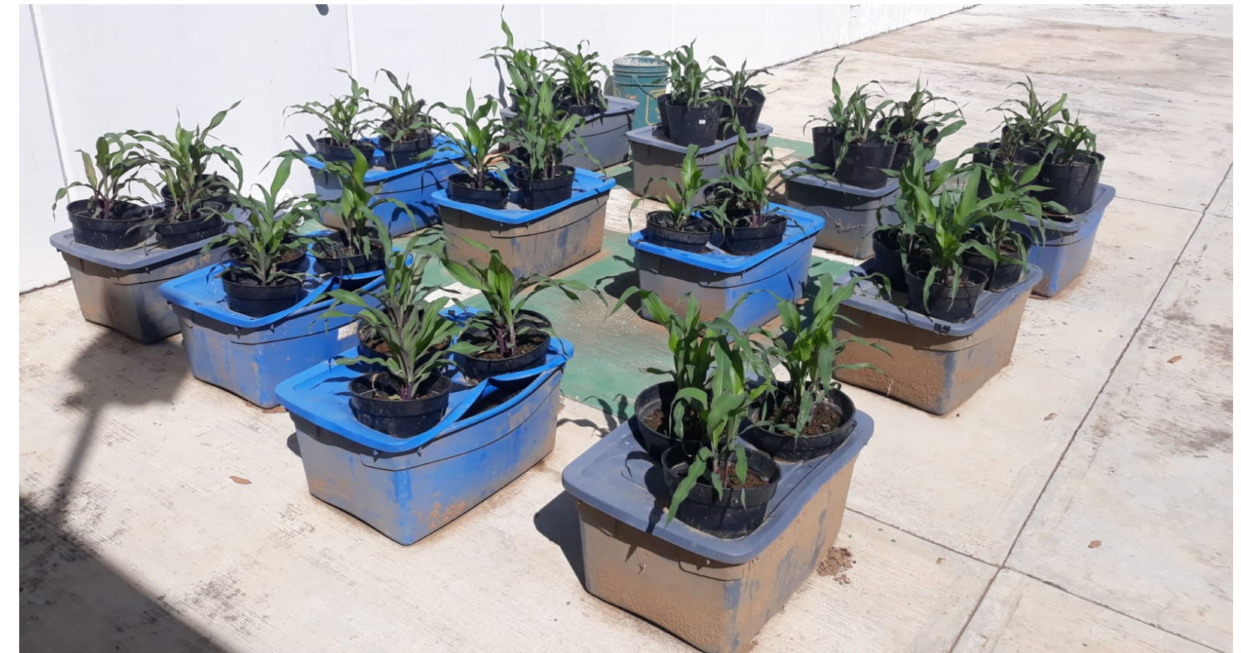
Figure 4. Maize plants of the second replica 15 days after having been sown according to the experimental matrix with a plant density of 200,000 plants ha − 1 .